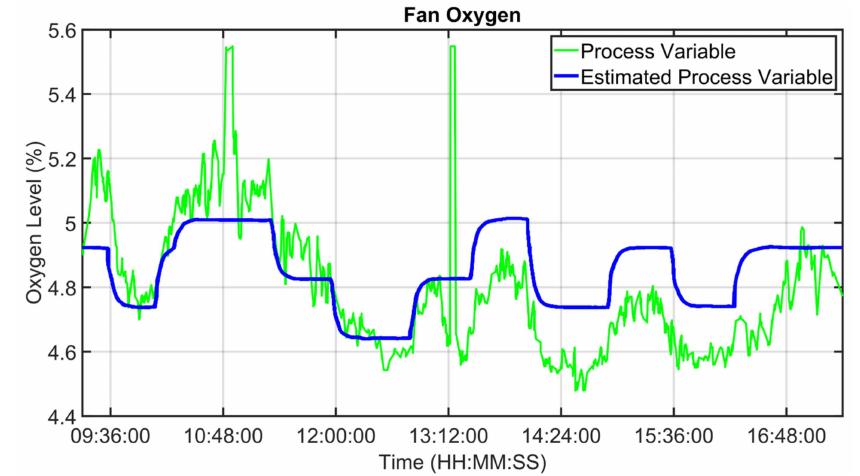
Figure 13. Rotary kiln APC system: modelization results (fan